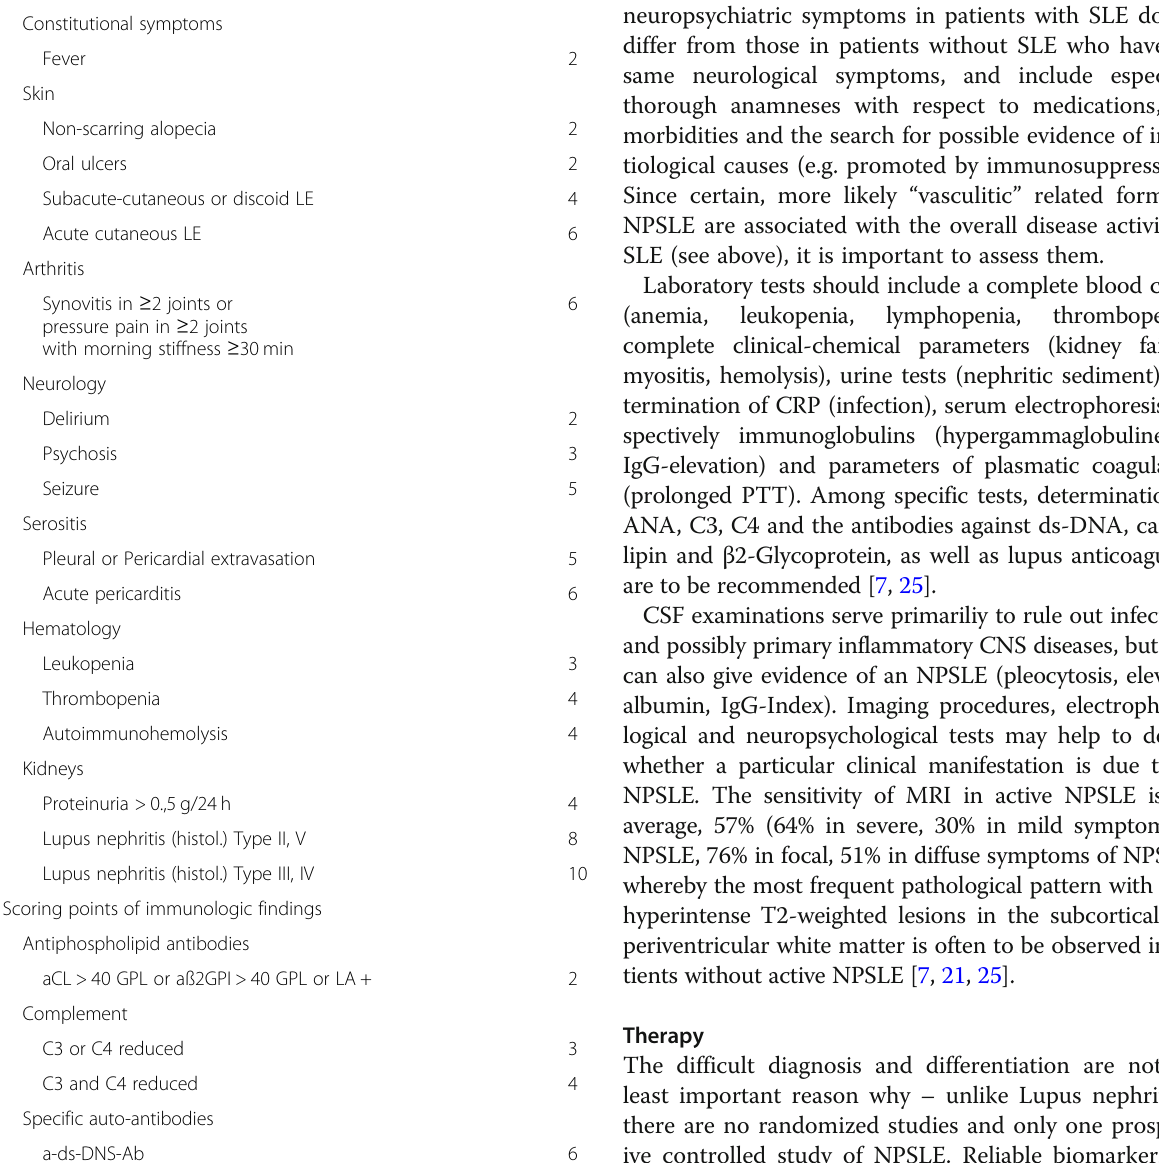
Table 7 EULAR/ACR-Classification Criteria for SLE (2018) Scoring points of organ